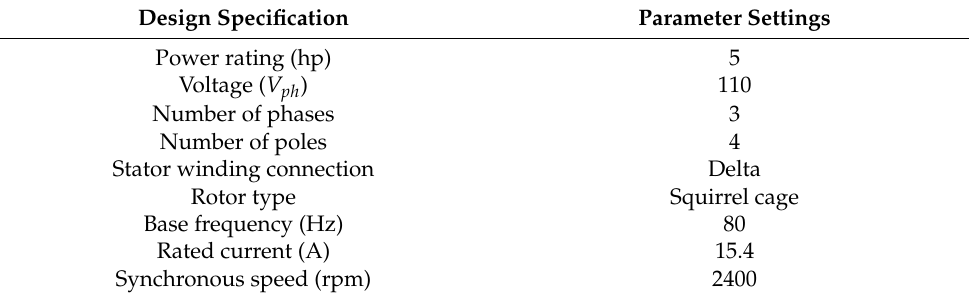
Table 1. Main design specifications of IM